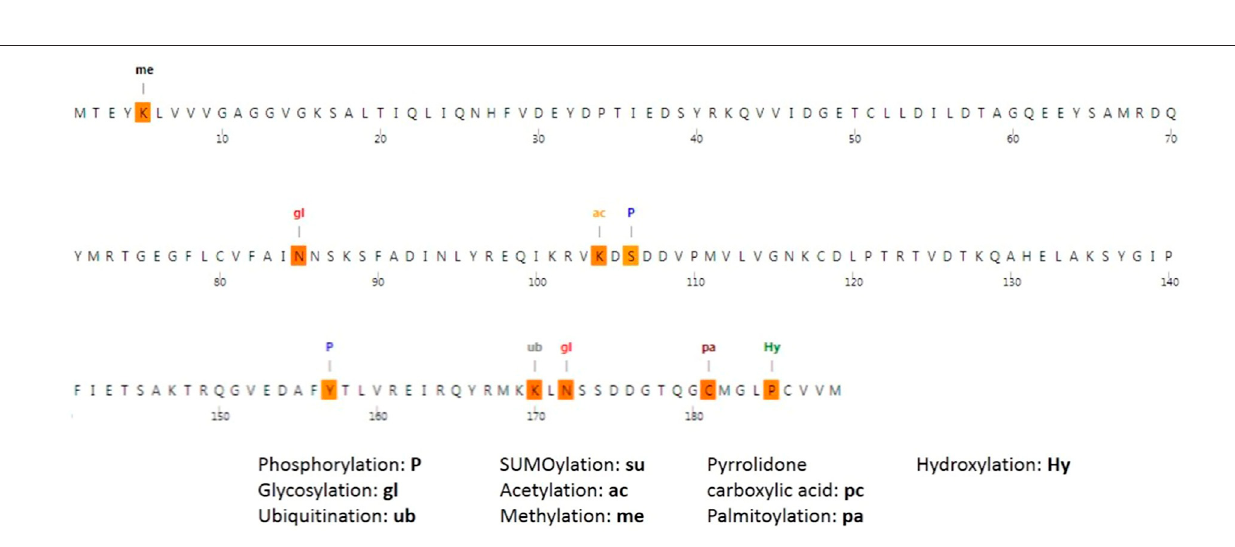
Frontiers in Genetics |